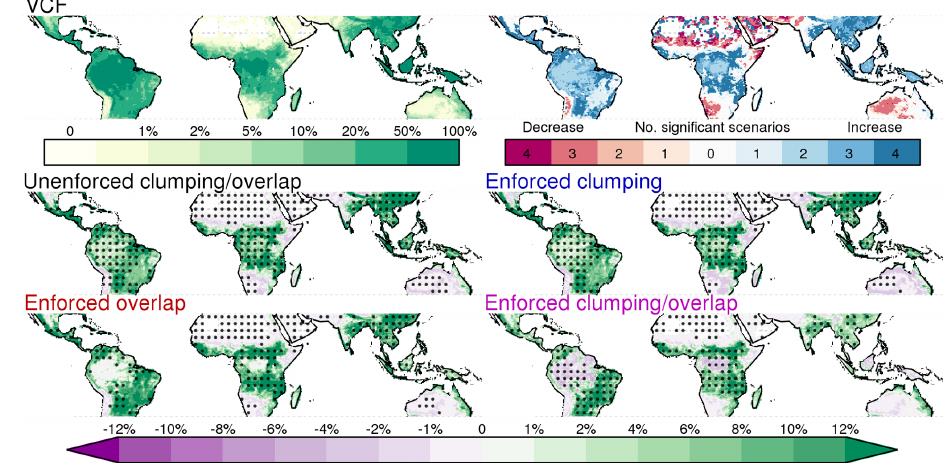
Figure A2. The change in tree cover post-calibration for all four scenarios. Black dots indicate areas where the post-calibration values have a 95% certainty of being positive (increasing cover) or negative (decreasing cover) calibrations. These uncertainty maps are indicators of areas where MODIS VCF estimates may be more or less reliable and cannot be used as definitive calibrations due to the limited number of field sites used as